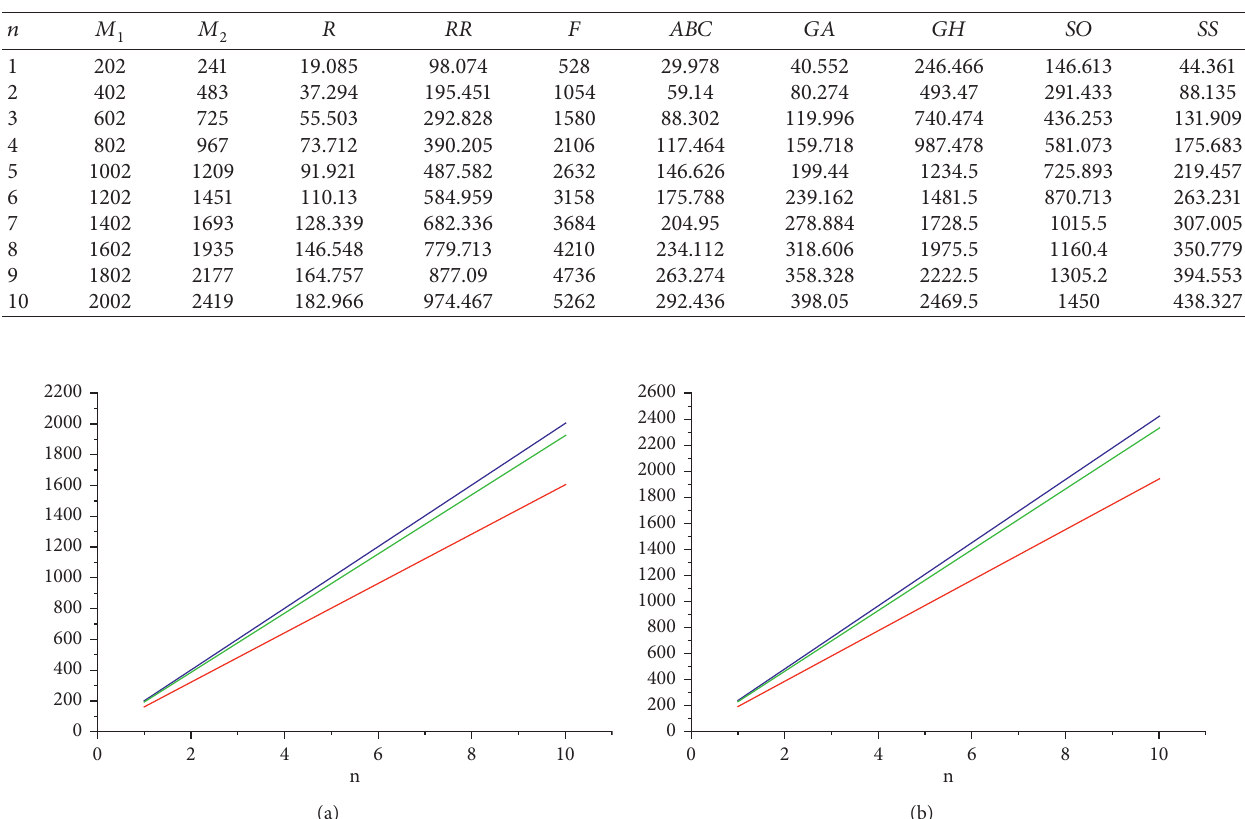
(guar gum) in red, M (HPG and CMG) in 1 1 (CMHPG) in blue. 2